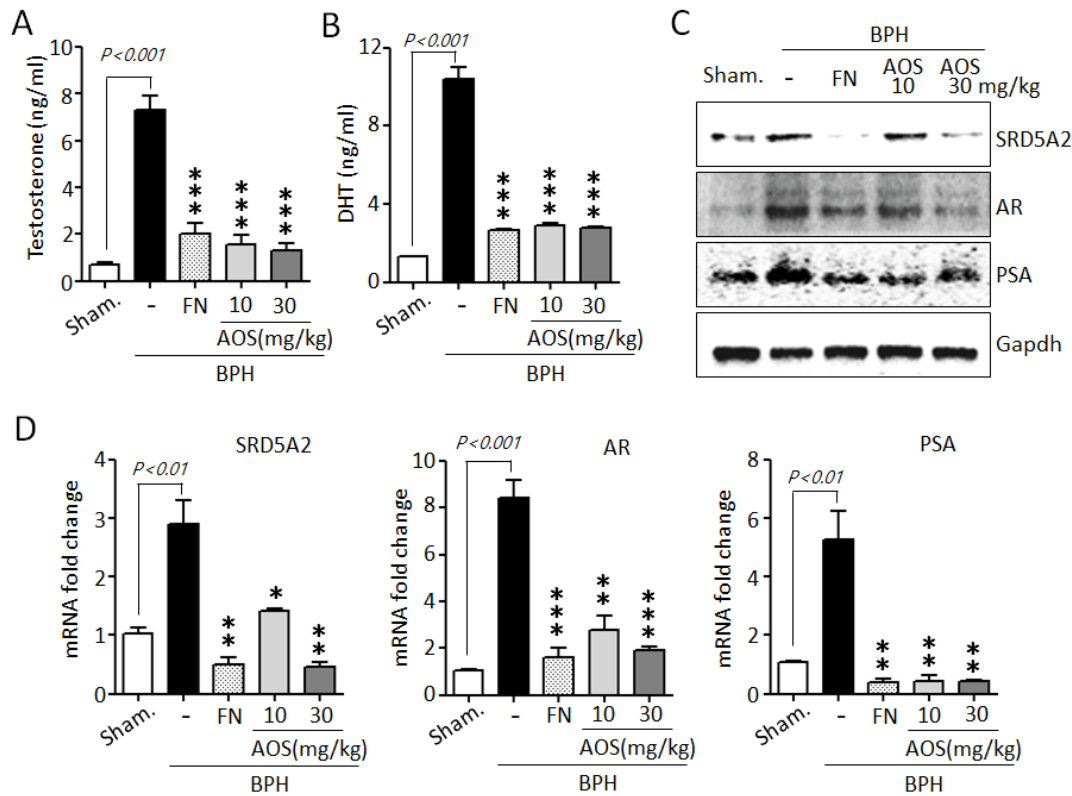
Figure 6. Effect of AOS on the expression of the serum levels of testosterone and dihydrotestosterone (DHT) and AR-associated genes in rats with testosterone propionate (TP)-induced benign prostate hyperplasia (BPH). Serum concentrations of testosterone ( A ) and DHT ( B ) using ELISA. ( C ) Total lysates (50 µ g/lane) were extracted and visualized using Western blotting by specific antibodies. Glyceraldehyde-3-phosphate dehydrogenase (Gapdh) was used as an internal control. Data are representative of three independent experiments. ( D ) Levels of expression of SRD5A2, AR, and PSA mRNA in prostatic tissues using real-time qPCR analysis. The data are presented as mean ± standard deviation ( n = 5 rats per group); * p < 0.05, ** p < 0.01, and *** p < 0.001 compared with the BPH/Veh group. Legend: Sham/Veh, the sham-operated group used as a negative control; BPH/Veh, castrated rats receiving TP + vehicle; BPH/FN, castrated rats receiving TP + finasteride; BPH/AOS, castrated rats receiving TP + different concentrations of AOS.